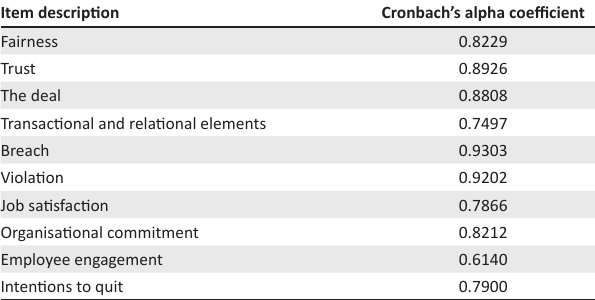
TABLE 2: Results from Cronbach’s